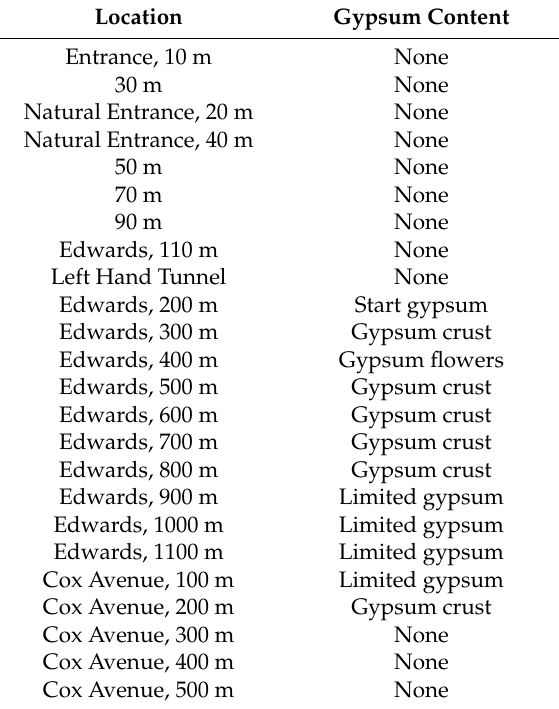
Table 1. Location of samples and extent of gypsum from the man-made entrance (E in Figure 1) along Edwards Avenue main cave passage and the Cox Avenue side passage. Location includes the number of meters from the entrance for Edwards Avenue and from the branch point from Edwards for Cox Avenue. Location Gypsum Content Entrance, 10 m None 30 m None Natural Entrance, 20 m None Natural Entrance, 40 m None 50 m None 70 m None 90 m None Edwards, 110 m None Left Hand Tunnel None Edwards, 200 m Start gypsum Edwards, 300 m Gypsum crust Edwards, 400 m Gypsum flowers Edwards, 500 m Gypsum crust Edwards, 600 m Gypsum crust Edwards, 700 m Gypsum crust Edwards, 800 m Gypsum crust Edwards, 900 m Limited gypsum Edwards, 1000 m Limited gypsum Edwards, 1100 m Limited gypsum Cox Avenue, 100 m Limited gypsum Cox Avenue, 200 m Gypsum crust Cox Avenue, 300 m None Cox Avenue, 400 m None Cox Avenue, 500 m